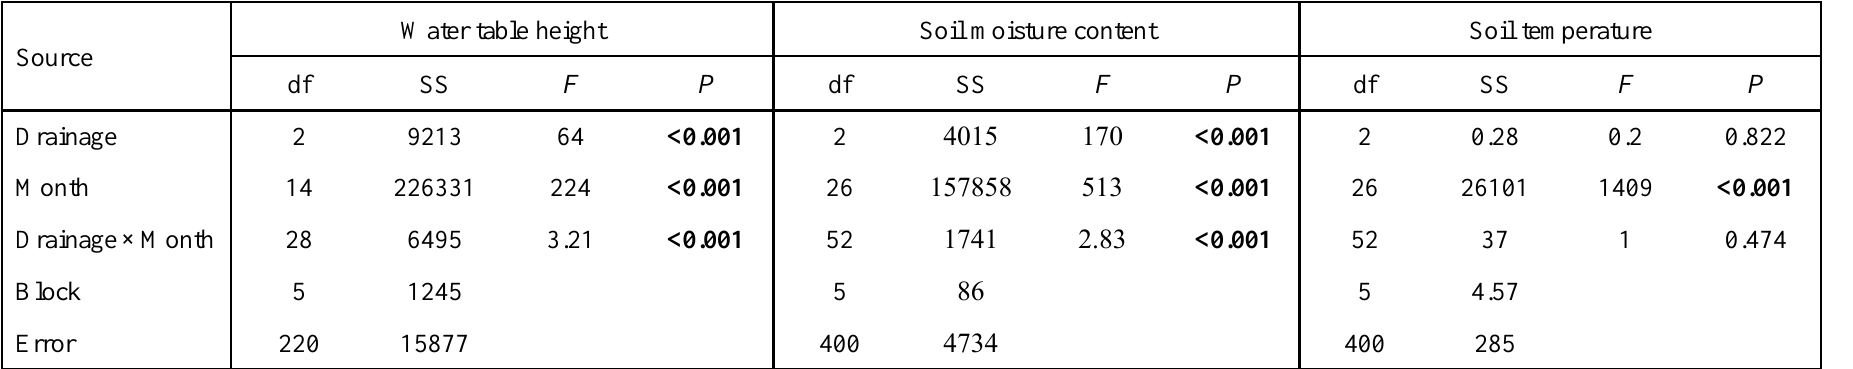
Table A1. Results (Degrees of freedom (df), Sum of squares (SS), F values and P values) of the Linear Mixed Model (LMM) showing the effects of drainage treatment (Drainage), monitoring month (Month) and their interactions on water table height, soil moisture content and soil temperature during the monitoring years. Values are considered significant if P < 0.05 (in bold